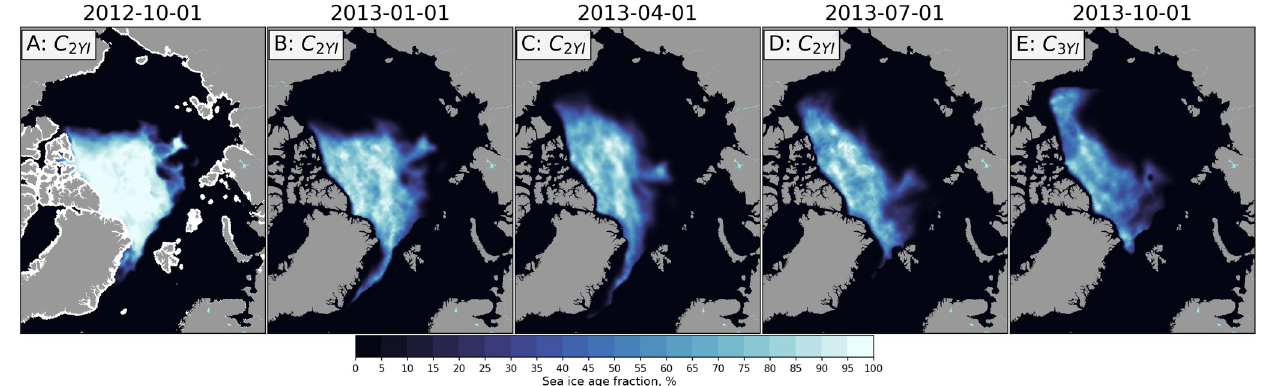
Figure 3. Example of advection of an ice fraction from 1 October 2012 to 1 October 2013 shown for every third